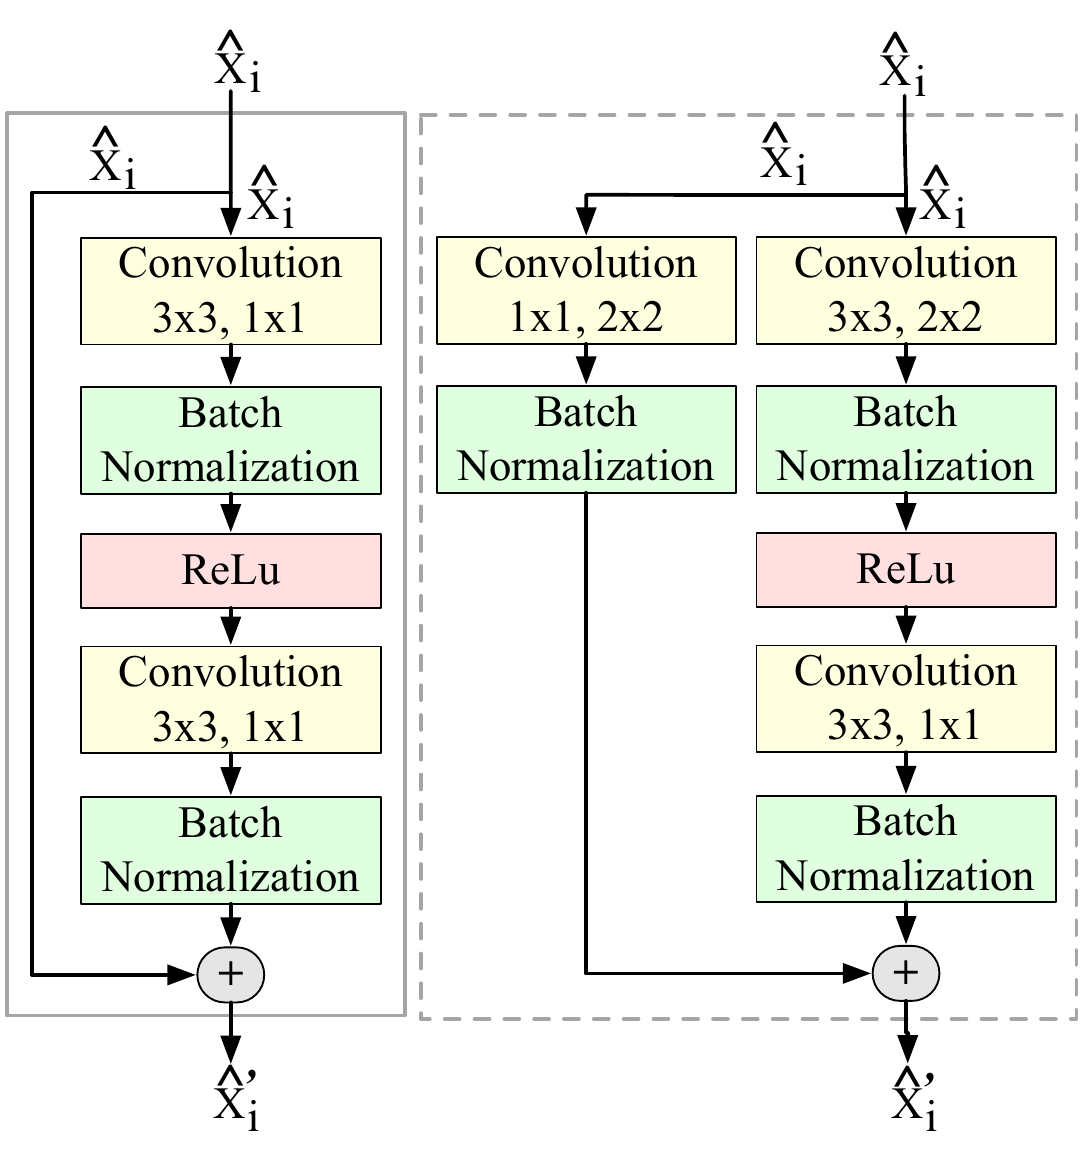
Figure 3. Architecture of residual